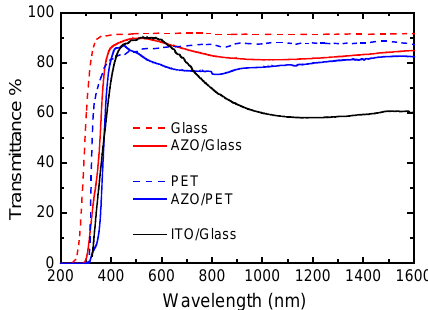
Figure 2. Transmittance spectra of AZO/glass and AZO/PET. Blank glass and PET spectra are also shown for reference, as well as commercial indium tin oxide (ITO)/glass.